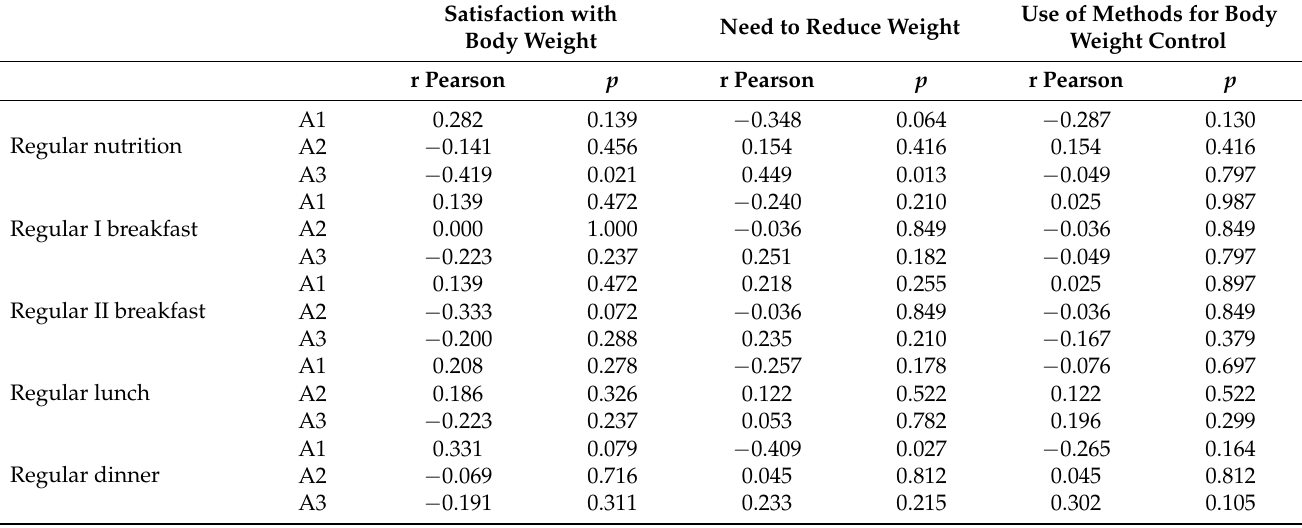
Table 7. Eating habits and satisfaction with body weight, a need to reduce it, and the use of methods for body weight control. Satisfaction